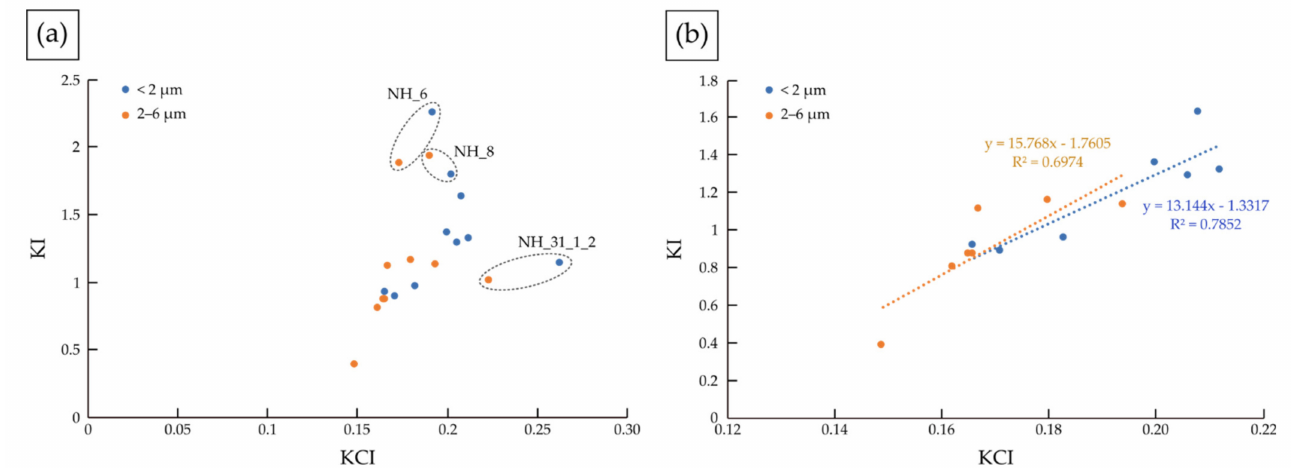
Figure 18. ( a ) Diagrams showing Kübler Index (KI) values versus the Kaolinite Crystallinity Index (KCI) for the clay fractions <2 µ m and 2–6 µ m. ( b ) Diagram showing positive correlations between KI and KCI for the clay fractions <2 µ m and 2–6 µ m, excluding samples NH_6, NH_8, and